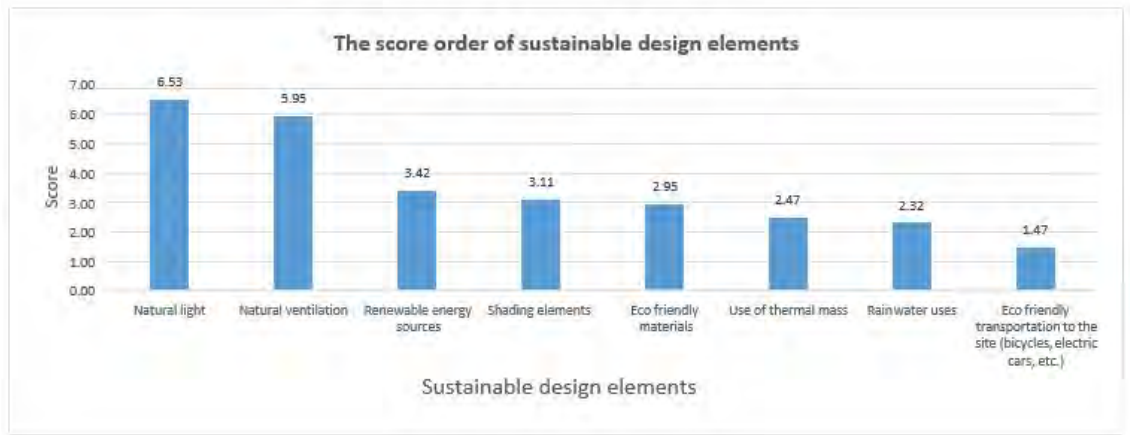
Figure 9. The natural light scored the highest points among the sustainable design